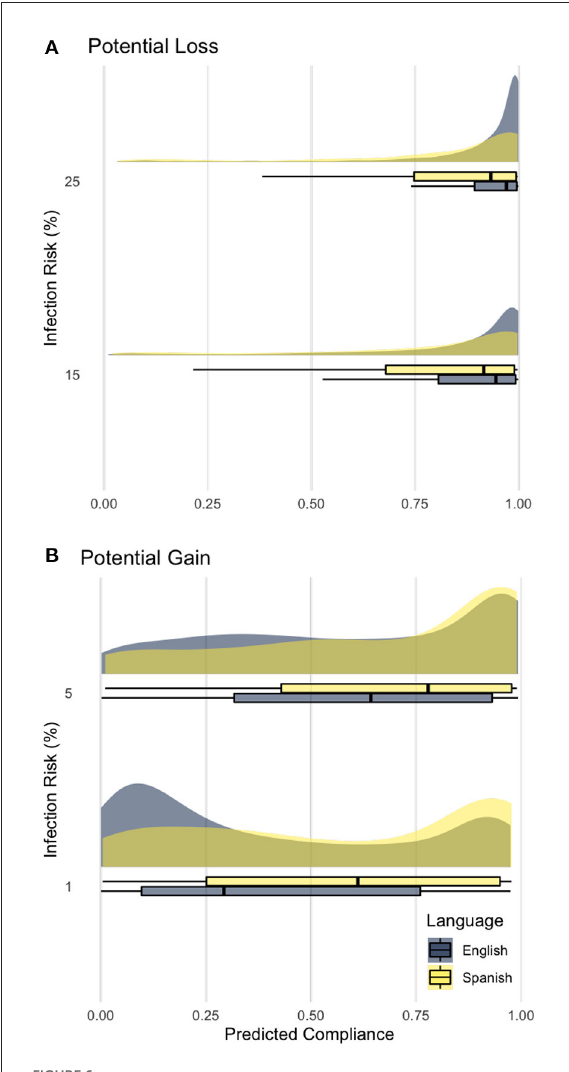
FIGURE6 Predicted compliance rate by infection risk and language groups. (A) 15, 25% risks yield potential loss without compliance; (B) 5, 1% risks yield potential gain with compliance.